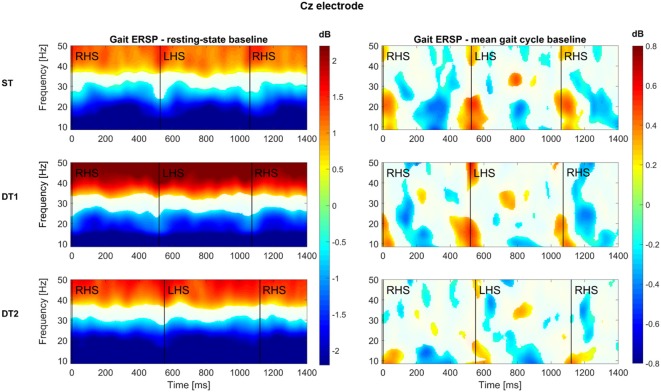
Group-level time-frequency analyses across conditions for Cz electrode. All subjects (N = 14) average time (x axis)—frequency (y axis) representations of the spectral power of the Cz electrode are here reported for each condition (first row: single-task walking; second row: dual-task1 walking; third row: dual-task2 walking). Two baseline approaches have been used: on the left hand side, the log spectrum of a 3 min period of resting state standing still with eyes-open was used; on the right hand side, the mean gait cycle log spectrum was employed. Color-bars (dB) are constant across conditions within each baseline approach and report increase (values >0, warm-color coded) and decrease (values <0, cold-color coded) of power spectrum with respect to each specific baseline. Group-level significance was calculated via bootstrapping method and FDR correction for multiple comparisons (p < 0.05) according to Wagner et al. (2012). A white mask was applied on those time-frequency bins (i.e., pixels) that did not pass the statistical test.